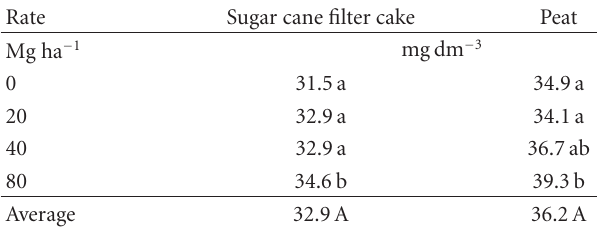
Table 2: Ba extracted from soil with the Mehlich-3 method ∗